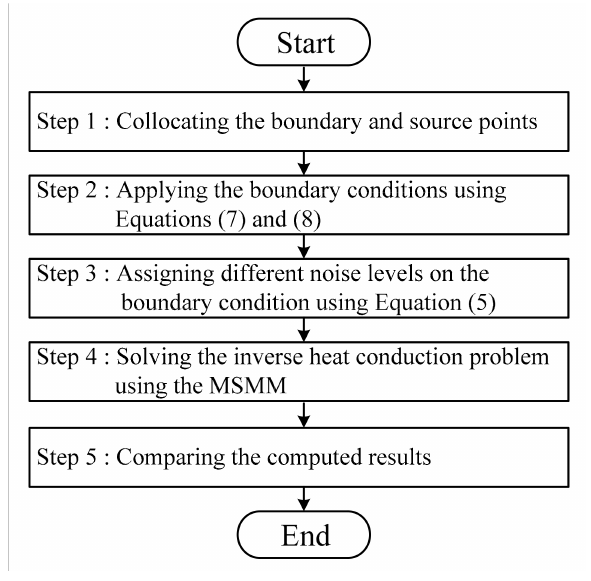
Figure 2. The flowchart of the